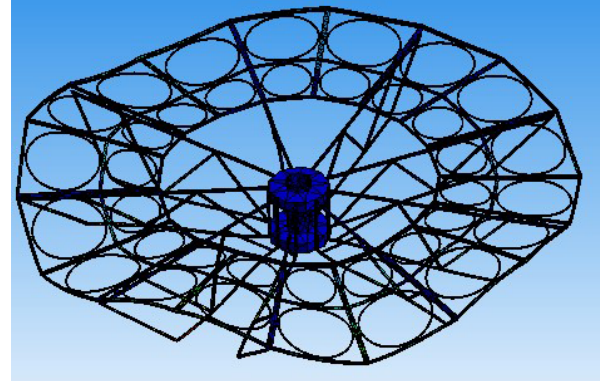
Figure 22. The second-order mode shape of the optimized free vi-